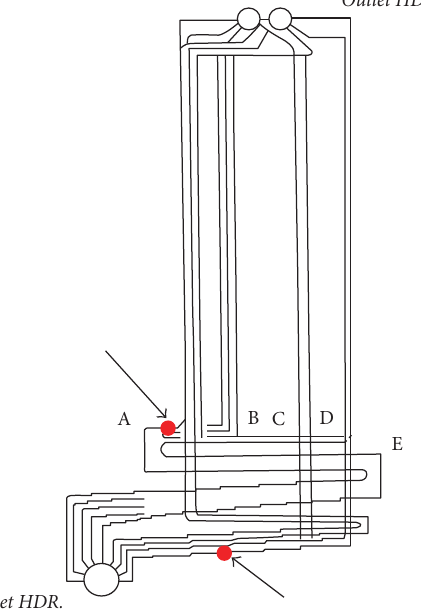
Figure 12: Schematic of the platen superheater with determined critical points.